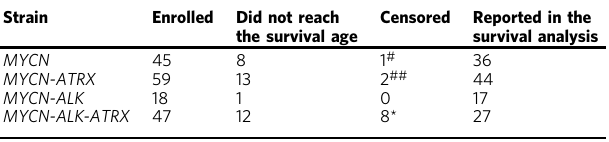
# Found dead no tumors. ## Hunched and lethargic no tumors, large spleen. *Malocclusion, four mice with fi ght wounds, paralysis hind limbs, found dead no tumors, large thymus